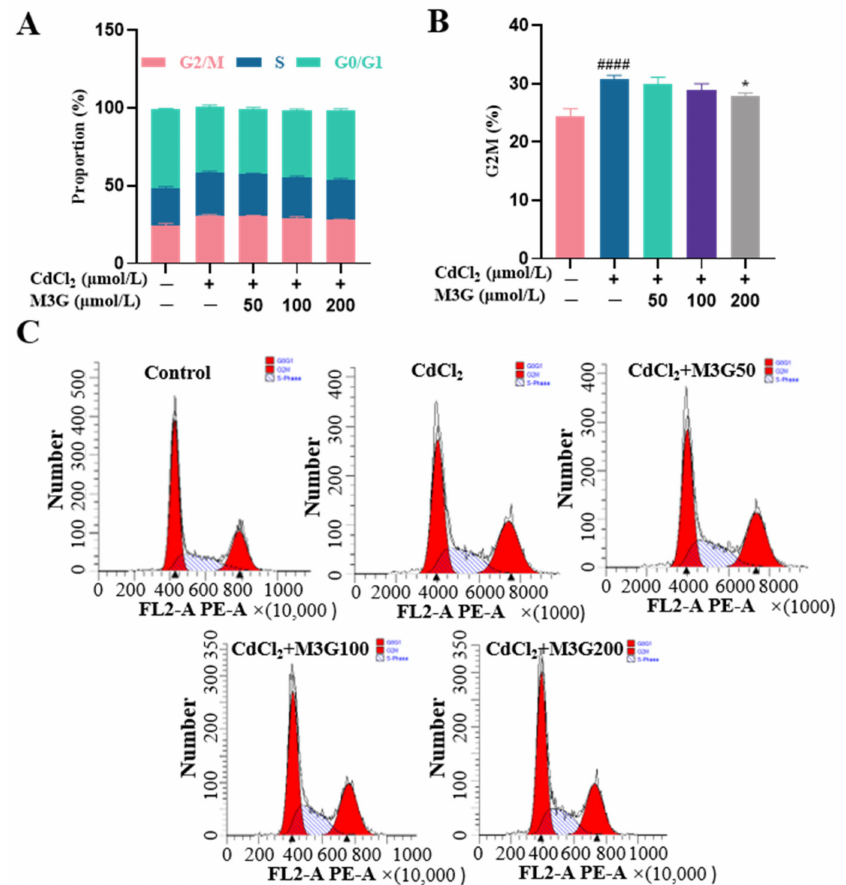
Figure 4. M3G inhibits the G2/M phase arrest caused by CdCl 2 exposure to KGN cells. Cell cycle of KGN cells after 24 h of exposure to 10 µ mol/L CdCl 2 and 50-200 µ mol/L M3G; ( A ) analysis of the cell cycle phases, the bar graph showing the G2/M, S, and G0/G1 phases; ( B ) analysis of the cell cycle phases, the bar graph showing the percentage of cells in G2/M phases; and ( C ) analysis of the cell cycle distribution. Mean ± SD, n = 3. #### p < 0.0001, vs. control; * p < 0.05, vs. CdCl 2 -treated